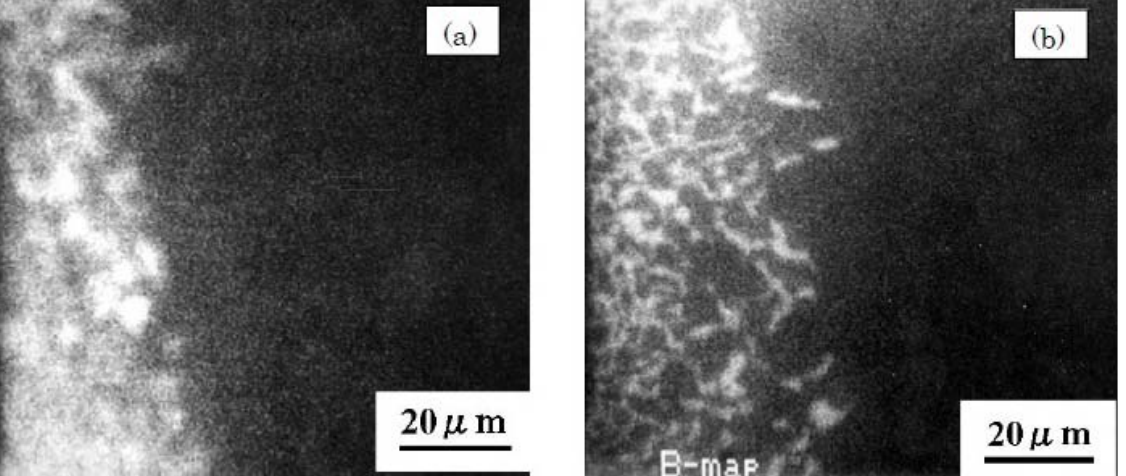
Figure 12. Classification of diffusion types according to Harrison. d and δ are grain width and grain boundary width, respectively. (D